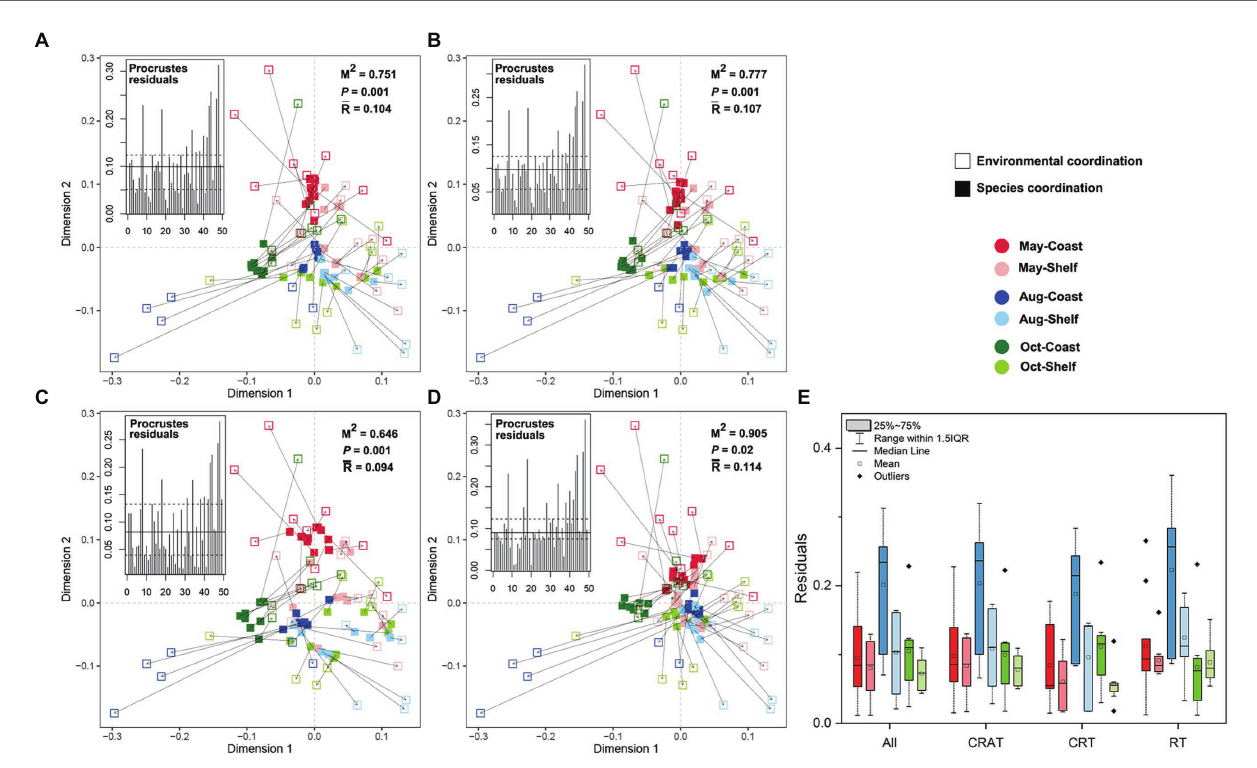
FIGURE 5 | Procrustes analyses of the correlations between environmental PCA coordination and community compositions’ PCoA coordination (based on Bray- Curtis distances) of each taxa dataset ( A . All; B . CRAT; C . CRT; and D . RT; M 2 , the Procrustes sum of squares; p , the significance under 999 permutations test; and R , the mean value of Procrustes residuals). The Procrustes residuals of each sample are shown at the left top and of six sampling groups are compared in the boxplot (E)